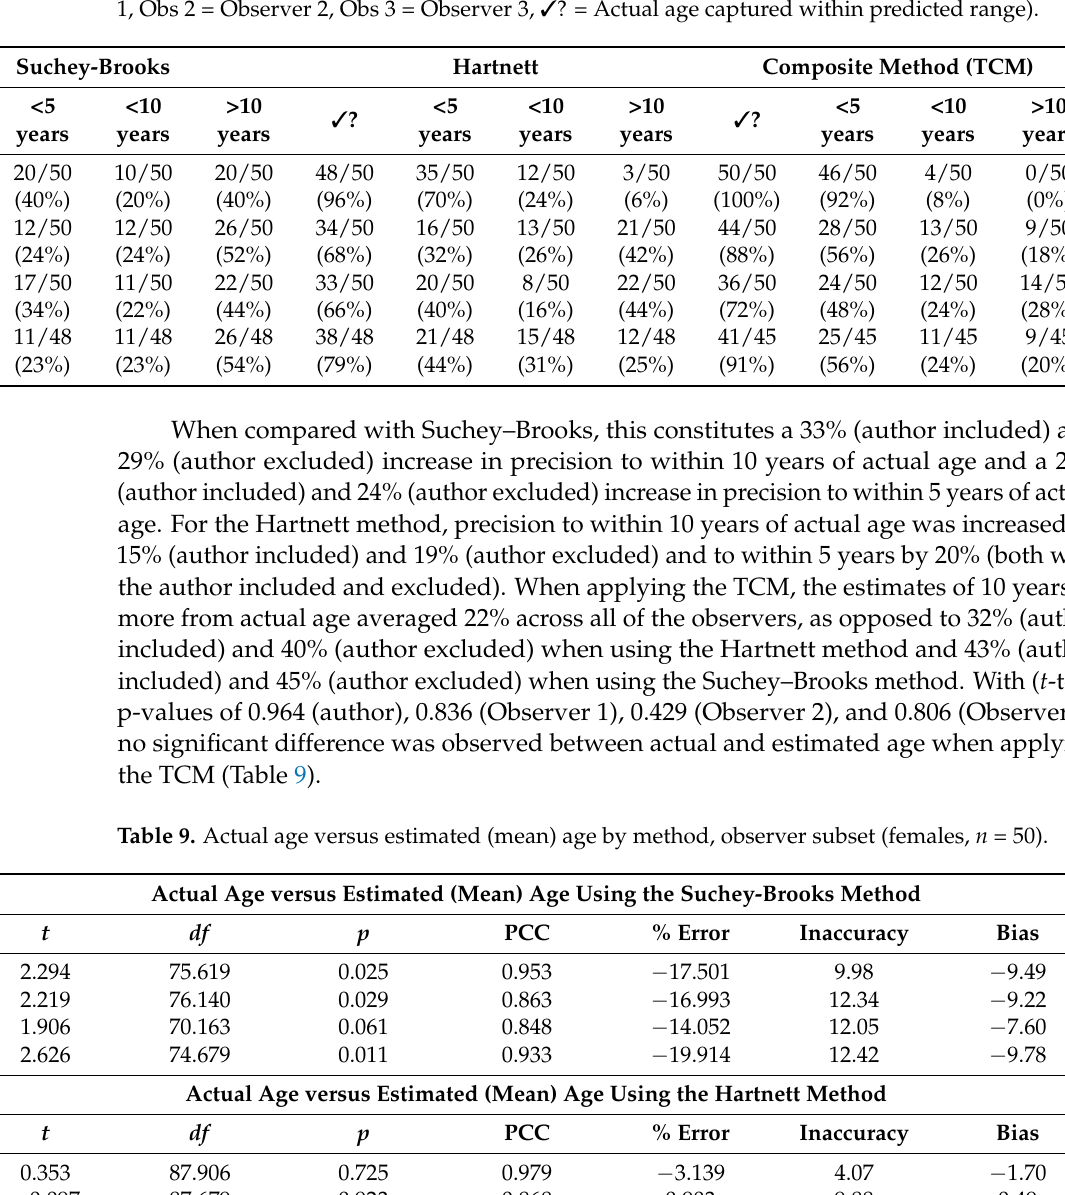
Table 8. Estimation accuracy by observer and method, observer subset (A = Author, Obs 1 = Observer